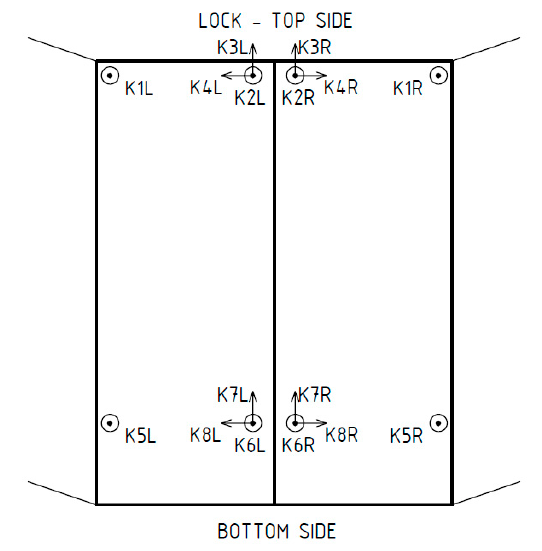
Figure 10 . Location of the control points on the gates and the direction of the acceleration measurements.